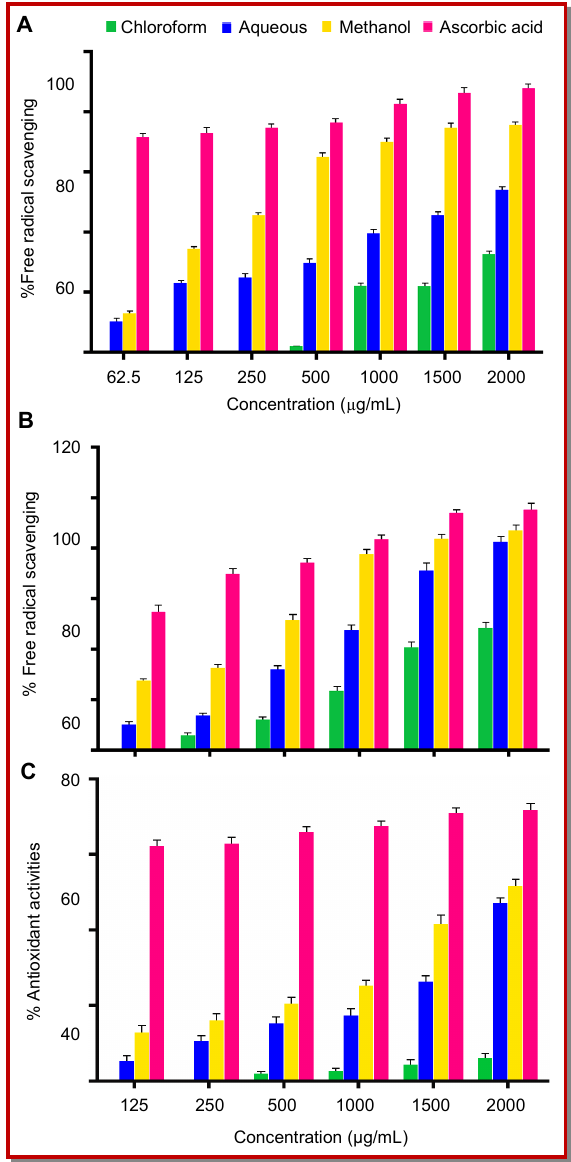
Figure 1: DPPH (A), ABTS (B) and H 2 O 2 (C) free radical scav- enging capability of I. aucheri leaves methanolic extract and